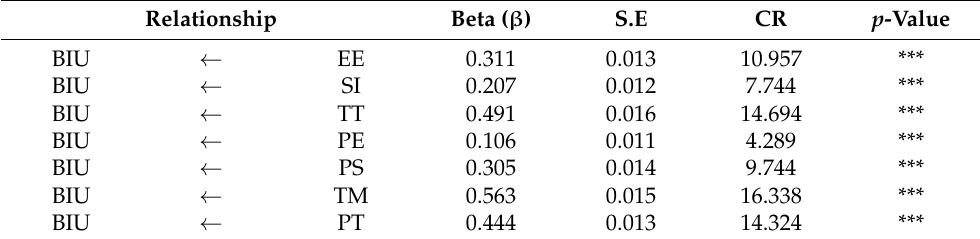
Table 3. Effects of independent variables on the dependent variable.